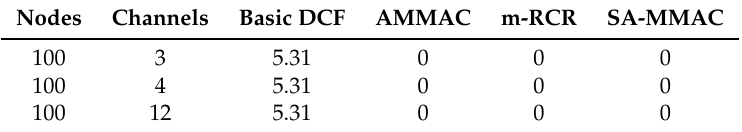
Figure 6. Comparison of Jain’s fairness index for SA-MMAC with other protocols. ( a ) 3 channels; ( b ) 4 channels; ( c ) 12 channels. Table 3. Comparison of the frame drop ratio (FDR) for 100 nodes, and 4 channels.